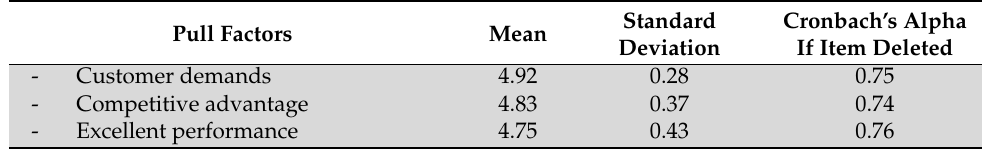
Table 11. Calculation of Q3 mean and Q1 standard deviation of the pull